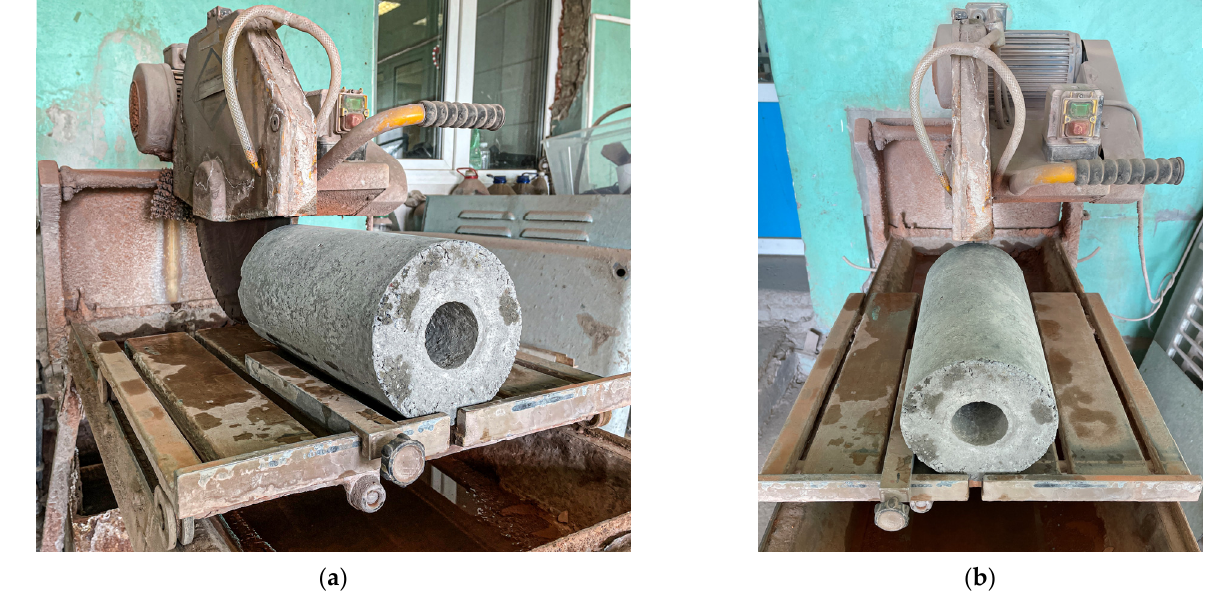
Figure 3. High-precision stone-cutting machine: ( a ) side view; ( b ) top view.